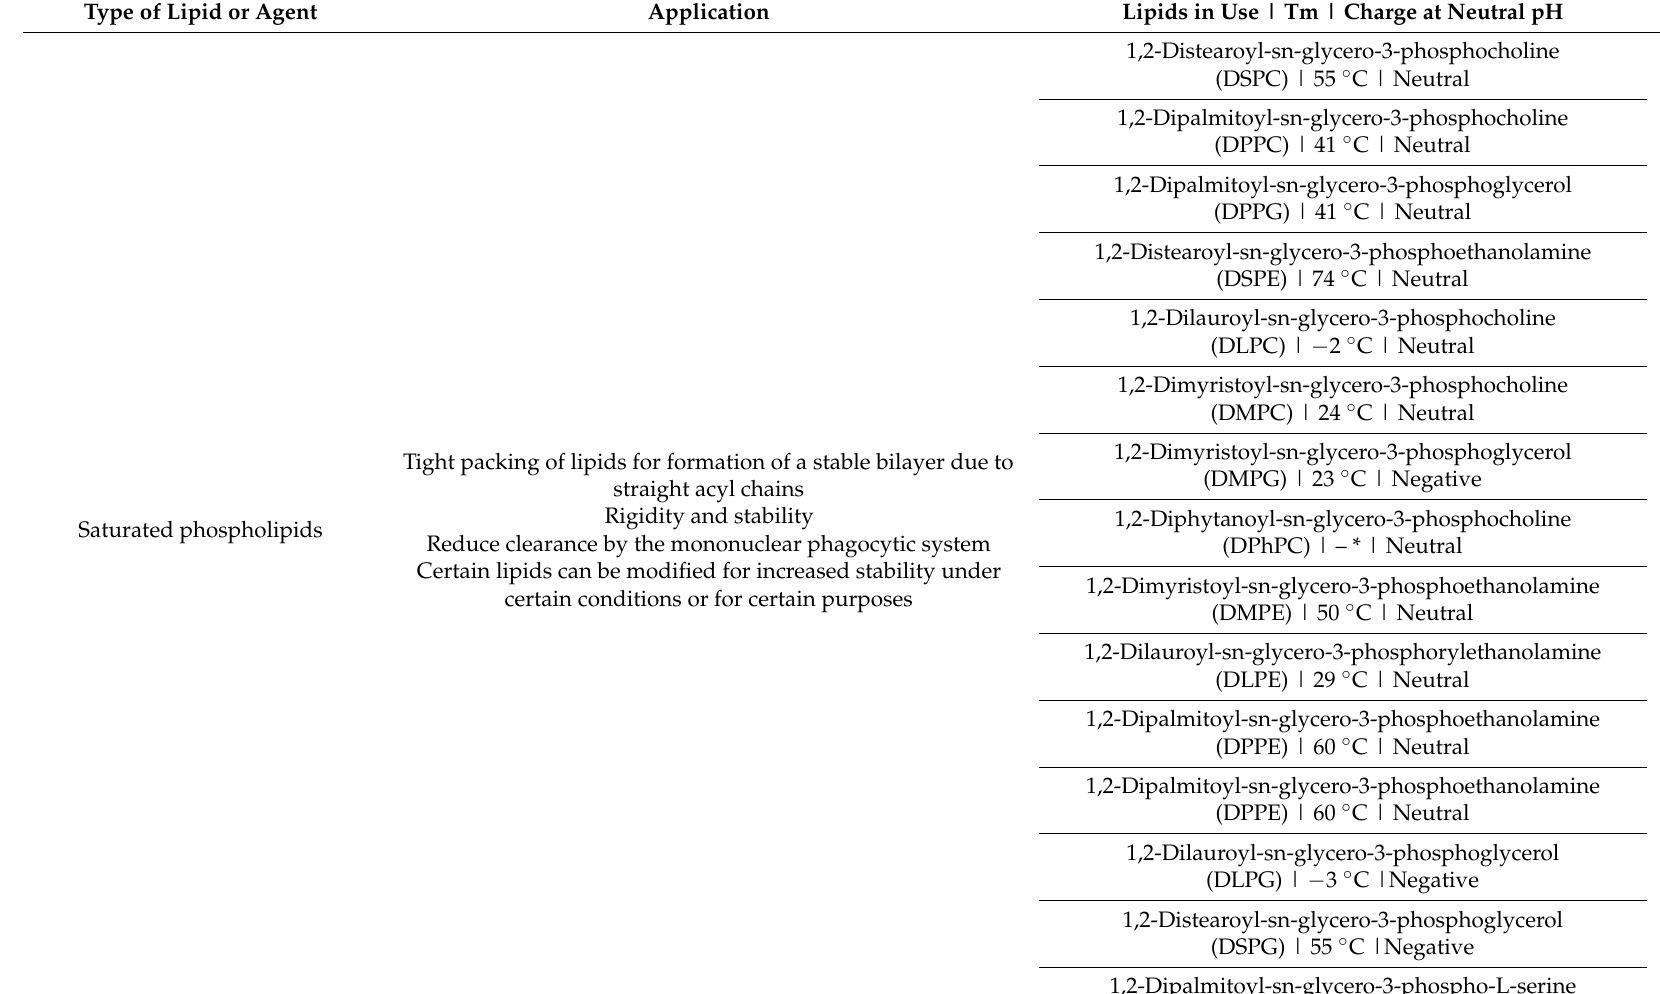
Table 2. Lipids and other agents commonly used in the formulation of